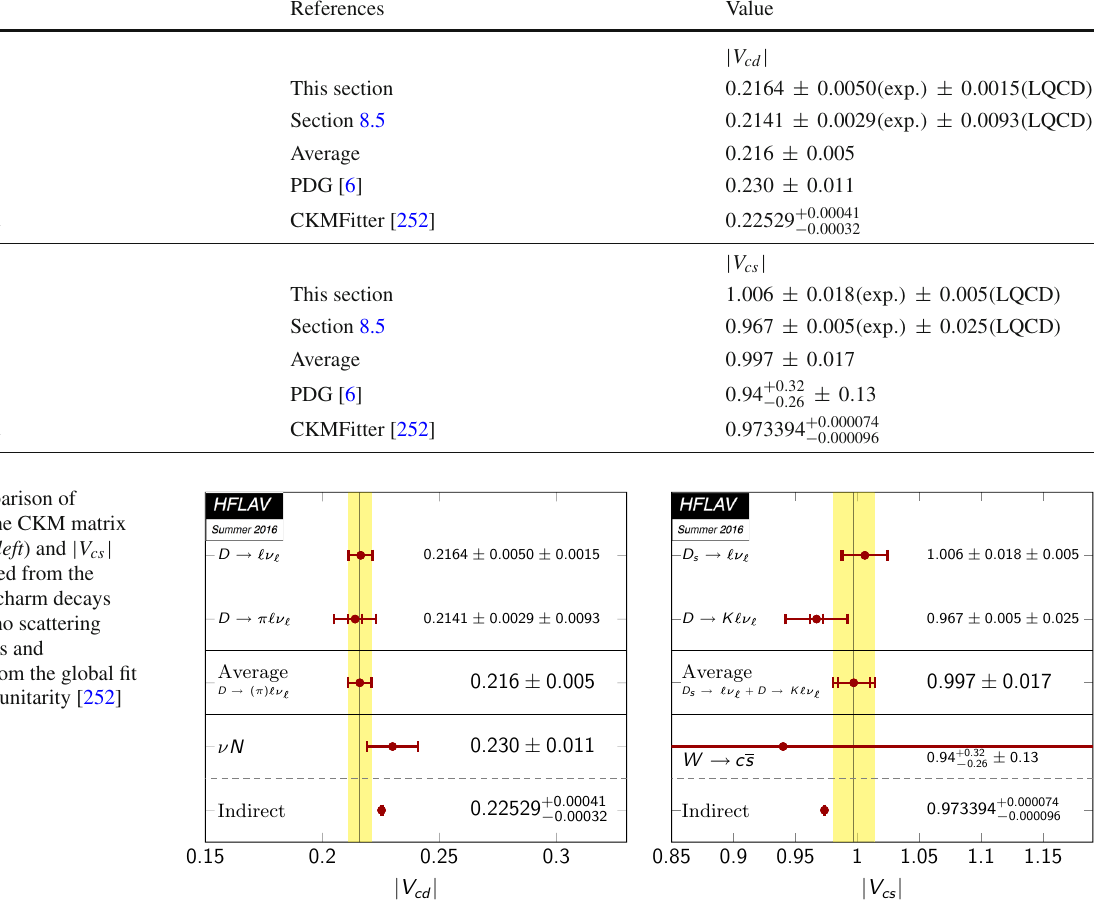
relations in uncertainties due to LQCD. The values determined from neutrino scattering or W decays and determination from the global fit to the CKM matrix are given for comparison as well